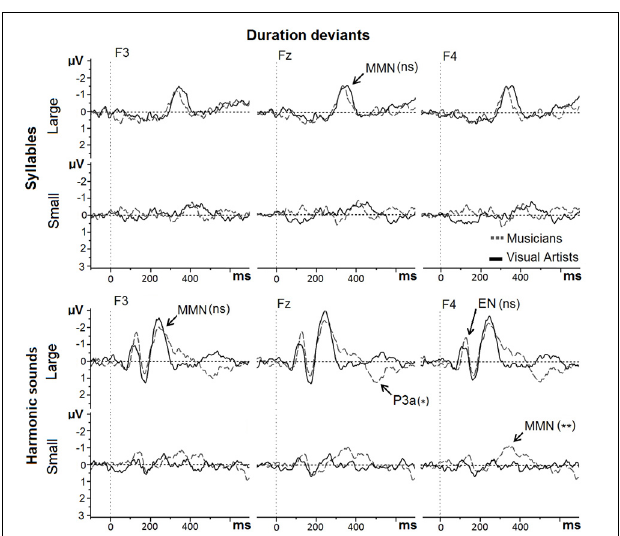
FIGURE 4 | MMNs to large and small duration deviants in Mandarin syllables and in harmonic sounds recorded at Frontal sites (F3, Fz, and F4) are overlapped for musicians (gray dashed line) and visual artists (black solid